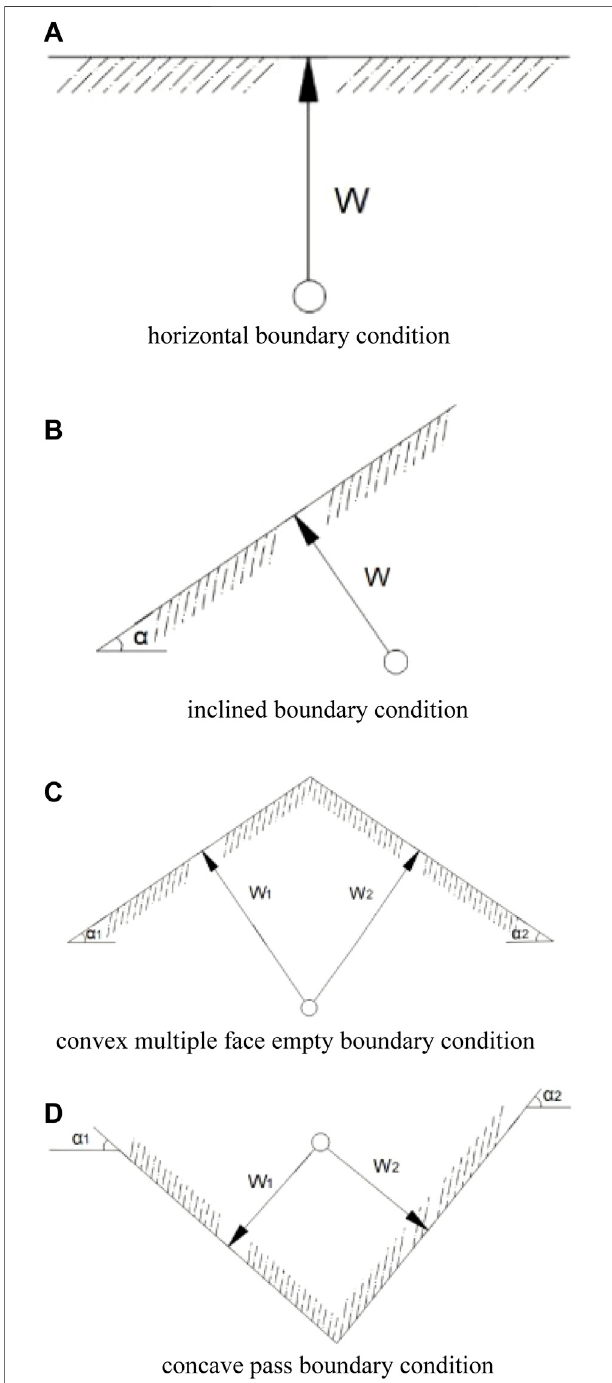
FIGURE 2 | Classi fi cation diagram of boundary